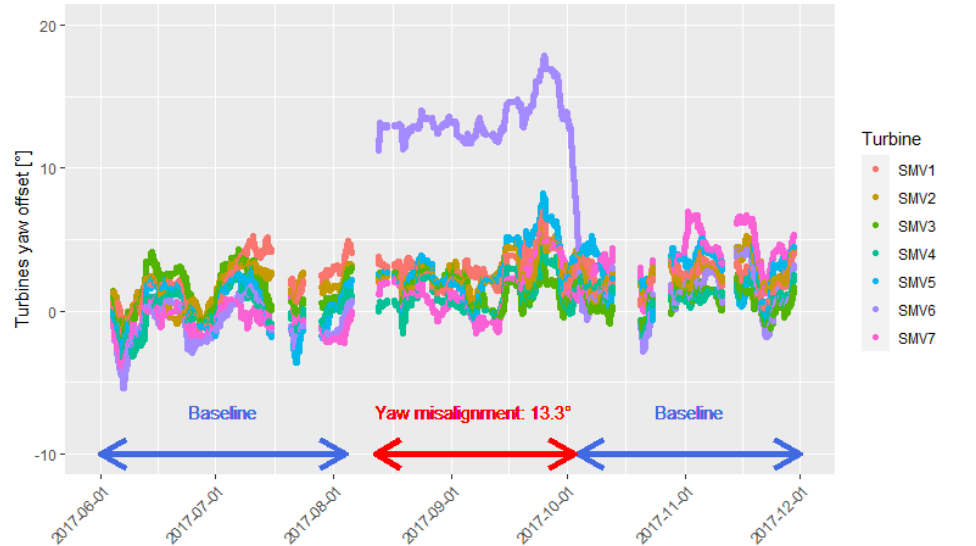
Figure 11. Evolution of the yaw offset of all turbines in the farm during the period of the analysis. The reference wind direction is taken from the Windcube lidar. To smooth out the time series, a moving average of 3d was applied. The periods corresponding to the baseline case and the wake steering case are marked by the arrows. The averaged misalignment angle on the SMV6 turbine is